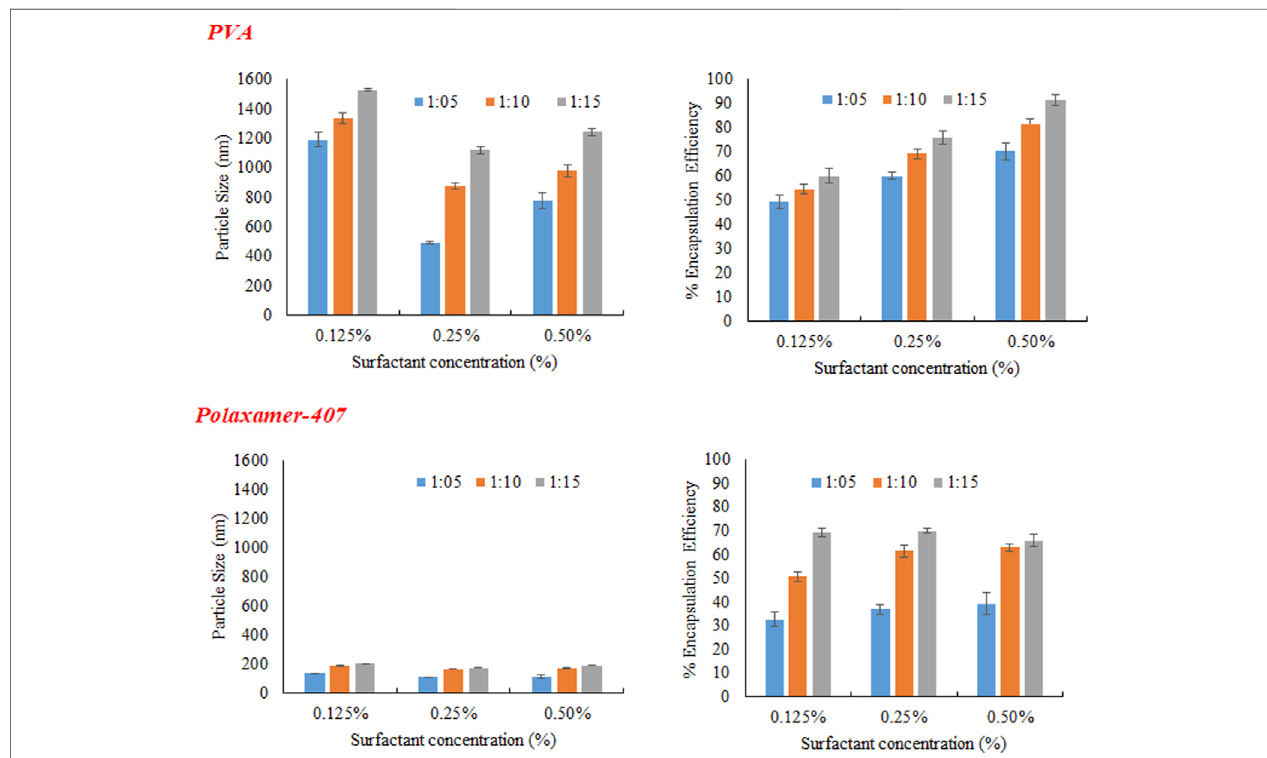
FIGURE 2 | Effect of Eudragit S100 conc. on (A) particles size (B) % Encapsulation ef fi ciency of MTX nanoparticles using different emulsi fi ers (PVA and Poloxamer-407).